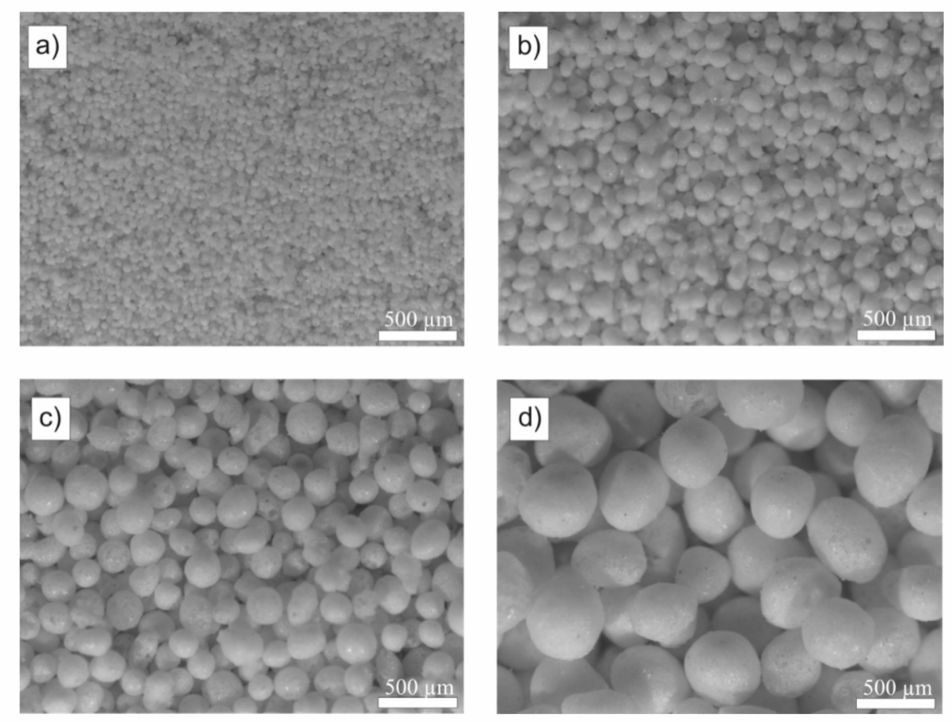
Figure 2. Optical images of glass microspheres: ( a ) Φ 1 , ( b ) Φ 2 , ( c ) Φ 3 and ( d ) Φ 4